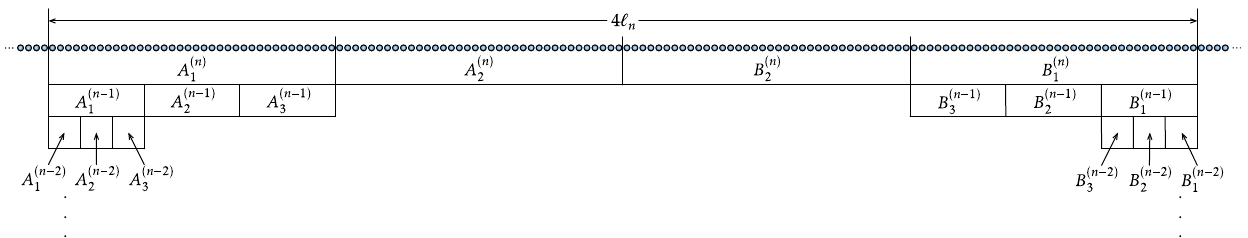
, is composed of four regions of n following the rule i − 1 l 3 i l 0 i ¼